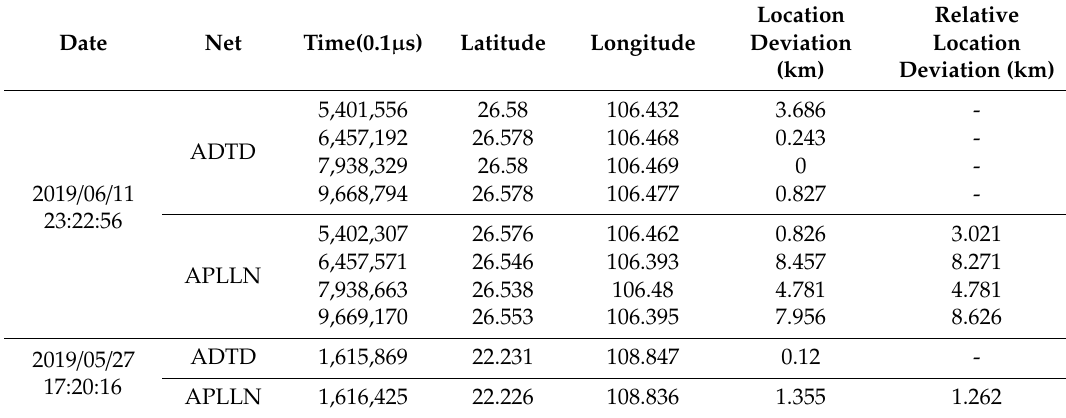
Table 3. The location results of the lightning location networks during two lightning accidents.